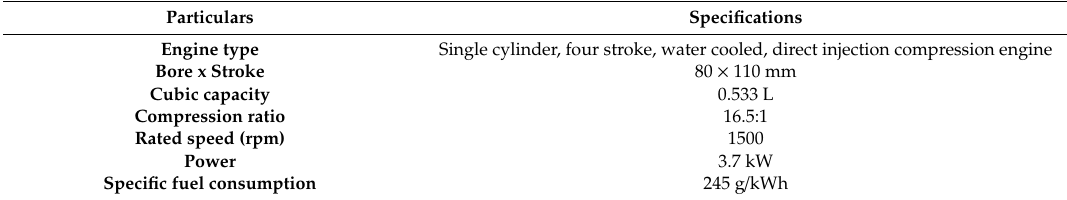
Figure 1. Pictorial view of experimental setup with gas analyzers and smoke meter. Table 4. Technical specifications of the test